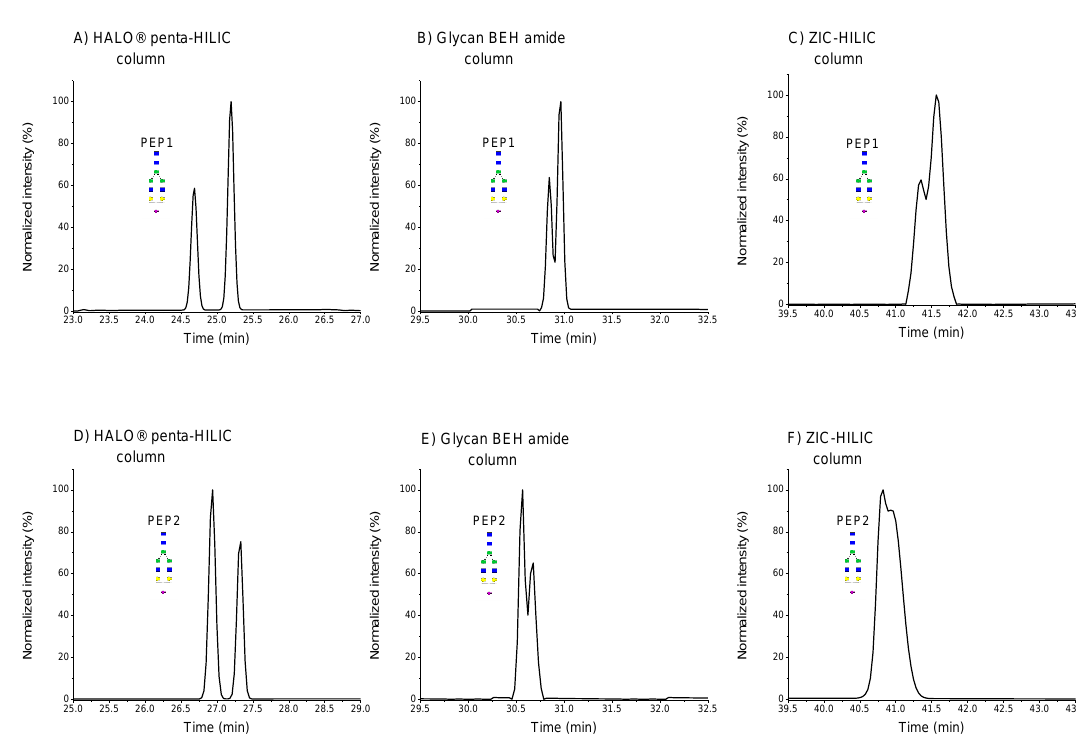
Figure 4. Normalized EIC chromatograms of A2G2S1 glycoforms of SWPAVGN 187 CSSALR ( A – C ) and ALPQPQN 453 VTSLLGCTH ( D – F ) in different HILIC columns. PEP1 refers to SWPAVGN 187 CSSALR, and PEP2 to ALPQPQN 453 VTSLLGCTH.